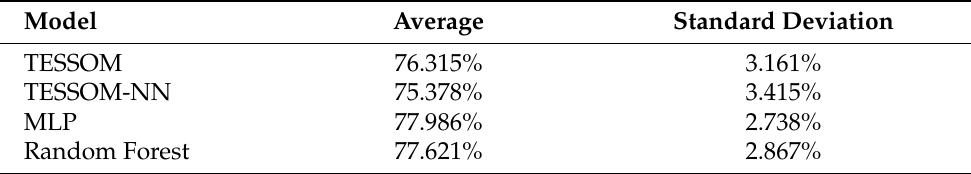
Table 9. Accuracy comparison—models trained with test